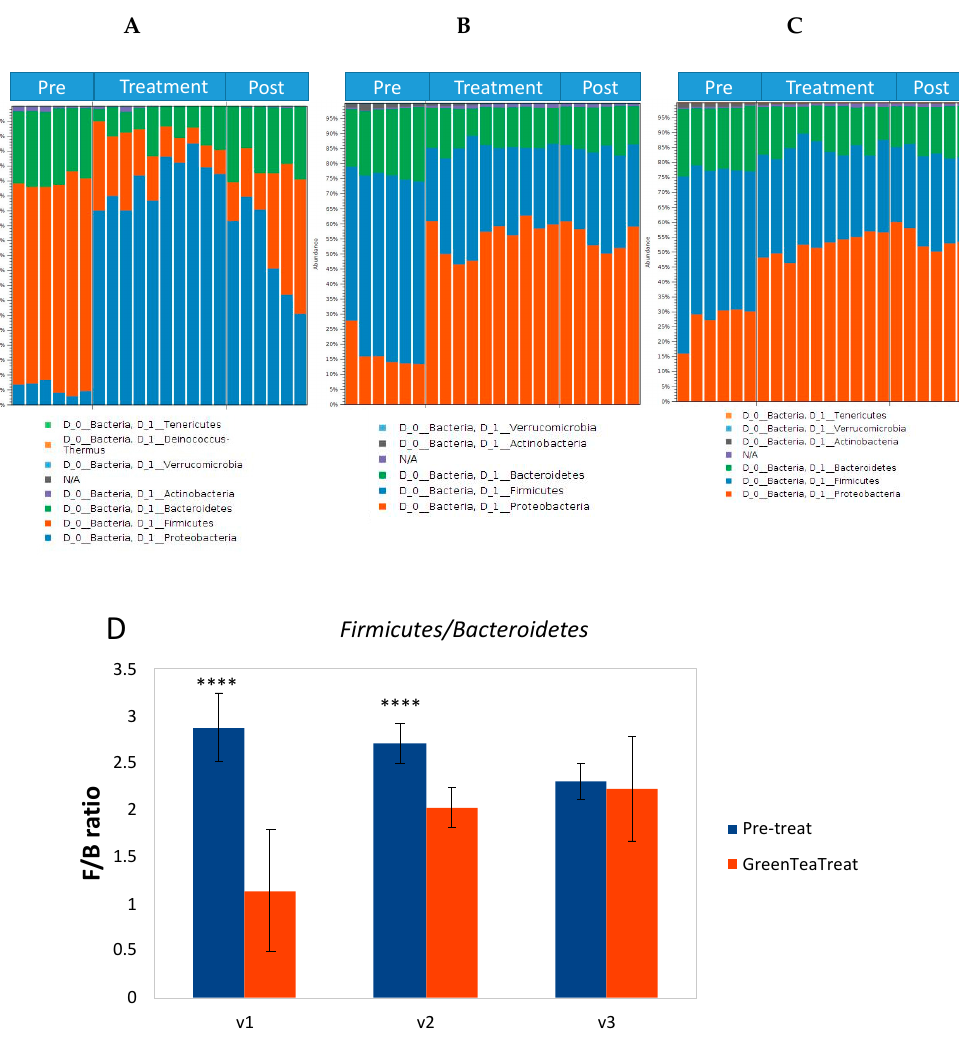
Figure 3. Bar charts representing bacterial taxonomy based on the 16 S rRNA gene at the phylum level in 3 parts of HCM (( A ). Vessel 1; ( B ). Vessel 2; ( C ). Vessel 3). ( D ). Firmicutes / Bacteroidetes ratio, n = 6